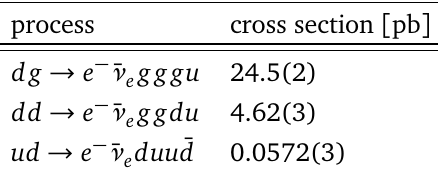
Table 3: Selection of partonic channels contributing to W + 4 jets production at the LHC and their corresponding leading-order production cross